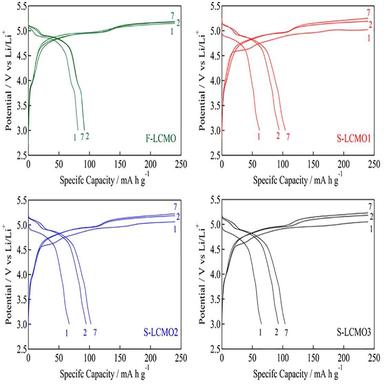
Charge and discharge curves of F-LCMO, S-LCMO1, S-LCMO2, and S-LCMO3 for initial 7 cycles.